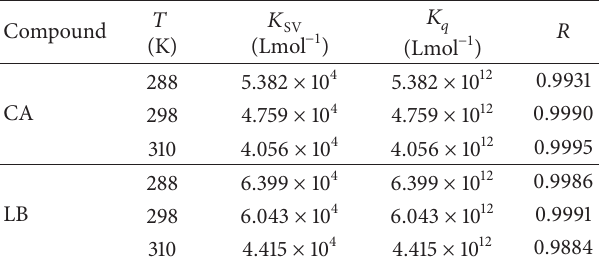
Table 1: Stern-Volmer quenching constant 𝐾 LB at different